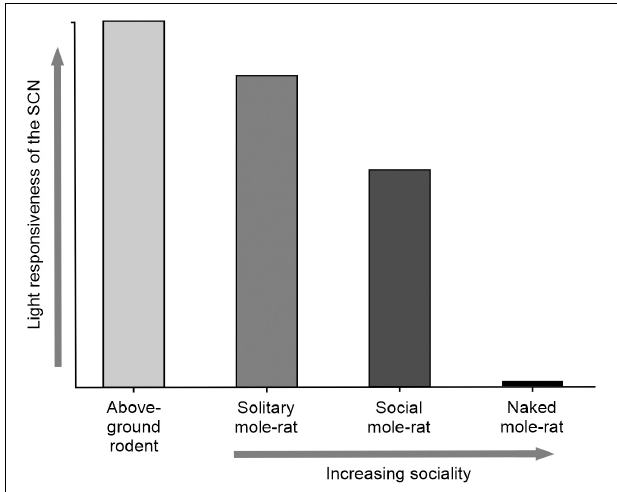
FIGURE 2 | An illustration of the light responsiveness of the SCN comparing aboveground rodents to mole-rats with different degrees of sociality. Aboveground dwelling rodents have a short integration time of light to the SCN and show gating of the circadian clock. Solitary mole-rats show similar gating of light compared to aboveground dwelling rodents but have a longer integration time/higher threshold to light. Social mole-rats do not show gating of the circadian clock and have higher and more variable thresholds to light. Naked mole-rats do not exhibit any Fos expression in the SCN in response to